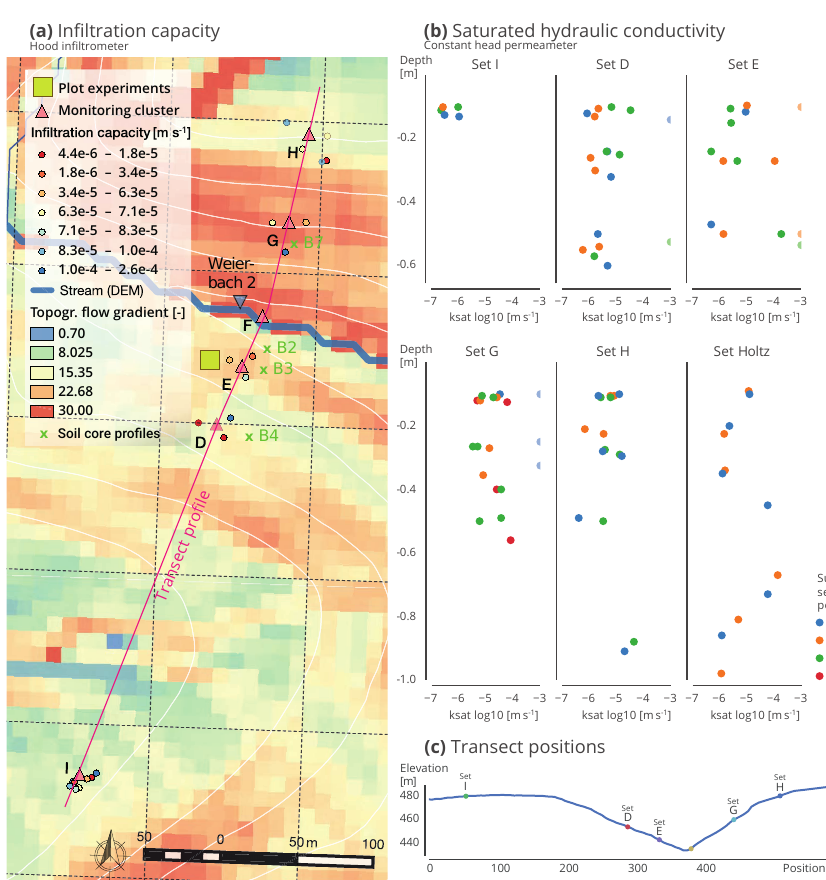
Figure B1. Hydrological exploration results. (a) Infiltration capacity (values color coded) measured with hood infiltrometer. Base map with topographic flow gradient G = arctan (∂z rel /∂d rel ) , topography contour lines and positions of hydro-meteorological monitoring clusters. (b) Saturated hydraulic conductivity measured with a constant head permeameter. Individual profile position in the respective nested set color coded (two measurement holes with dist = 1m). Values exceeding the device capacity set to 10 − 3 ms − 1 . (c) Elevation profile of the transect as a characteristic landscape feature in the sub-basin.